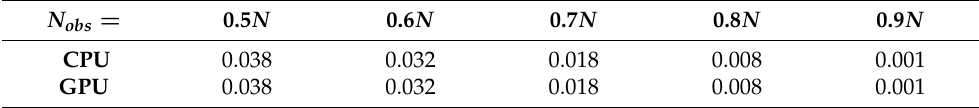
Table 3. Average relative mean square errors (rMSEs) under varying observing